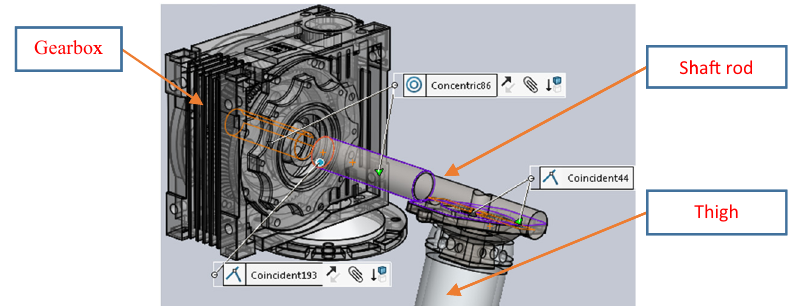
Figure 6: Rotational motion between gearbox and shaft.